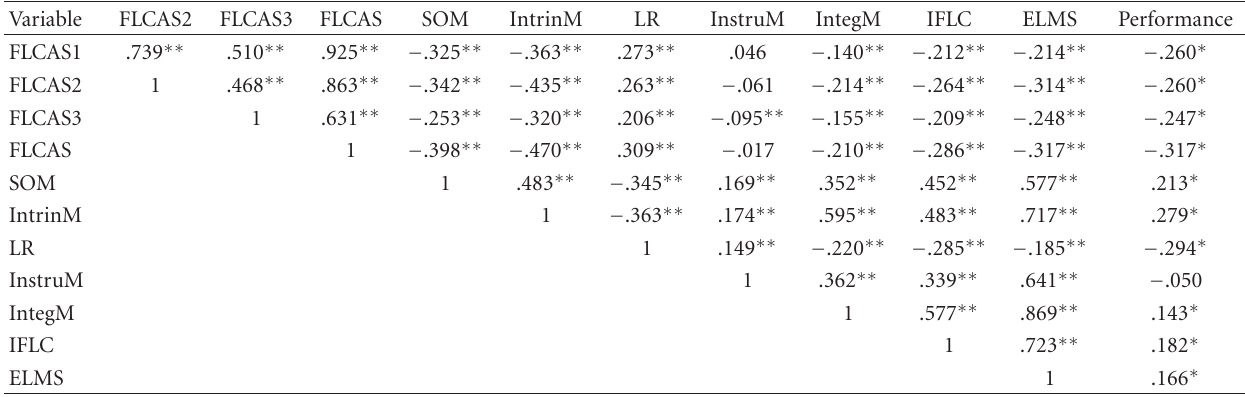
Table 3: Correlations among the measured variables and performance ( N = 980).